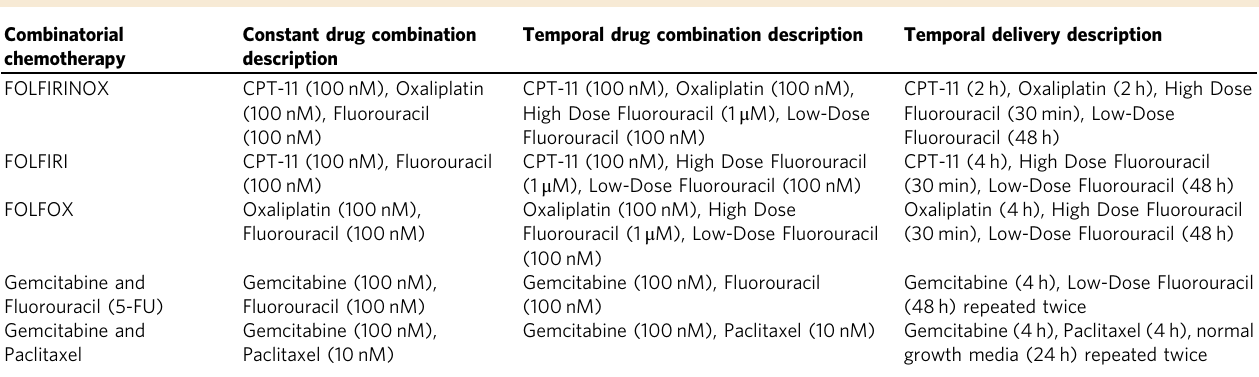
Fig. 3 Combinatorial drug treatment of human tumor organoids on micro fl uidic platform. a On-platform drug treatment and stimulation with continuous fl uorescence and phase imaging of organoids for the treatment duration. Each color represents a different drug formulation. Drug treatments on each channel can be changed on demand, creating time-varying drug treatments. Organoids can be analyzed for growth, morphology changes, or death. b Representative images (10×) of gemcitabine (100 nM) treated organoids for a 4-h drug pulse followed by normal growth media, continuous treatment of paclitaxel (10 nM) for 72-h, continuous treatment of gemcitabine (100 nM) for 72-h, a combination dose of gemcitabine (100 nM) + paclitaxel (10 nM) for 72-h, and negative and positive controls (staurosporine 10 mM). Caspase 3/7 reagent (green) used for apoptosis detection and propidium iodide (red) for dead cells along with phase contrast images (scale bar 100 μ m). c Average caspase 3/7 signal over 72-h period of continuous single drug treatments for patient 1. d Average caspase 3/7 signal over 72-h period for a 4-h pulse of a single drug treatment followed by normal growth media for patient 1. e, f 72-h ( e ) and 4-h ( f ) drug treatments similarly examined for multiple known combinations of drugs. c – f All data presented as mean values ± SEM, n = 3, and normalized to positive control. Overall, combination chemotherapy treatment resulted in signi fi cantly increased apoptosis in tumor organoids compared to single drug treatments as expected. Source data for panels e , f are available.